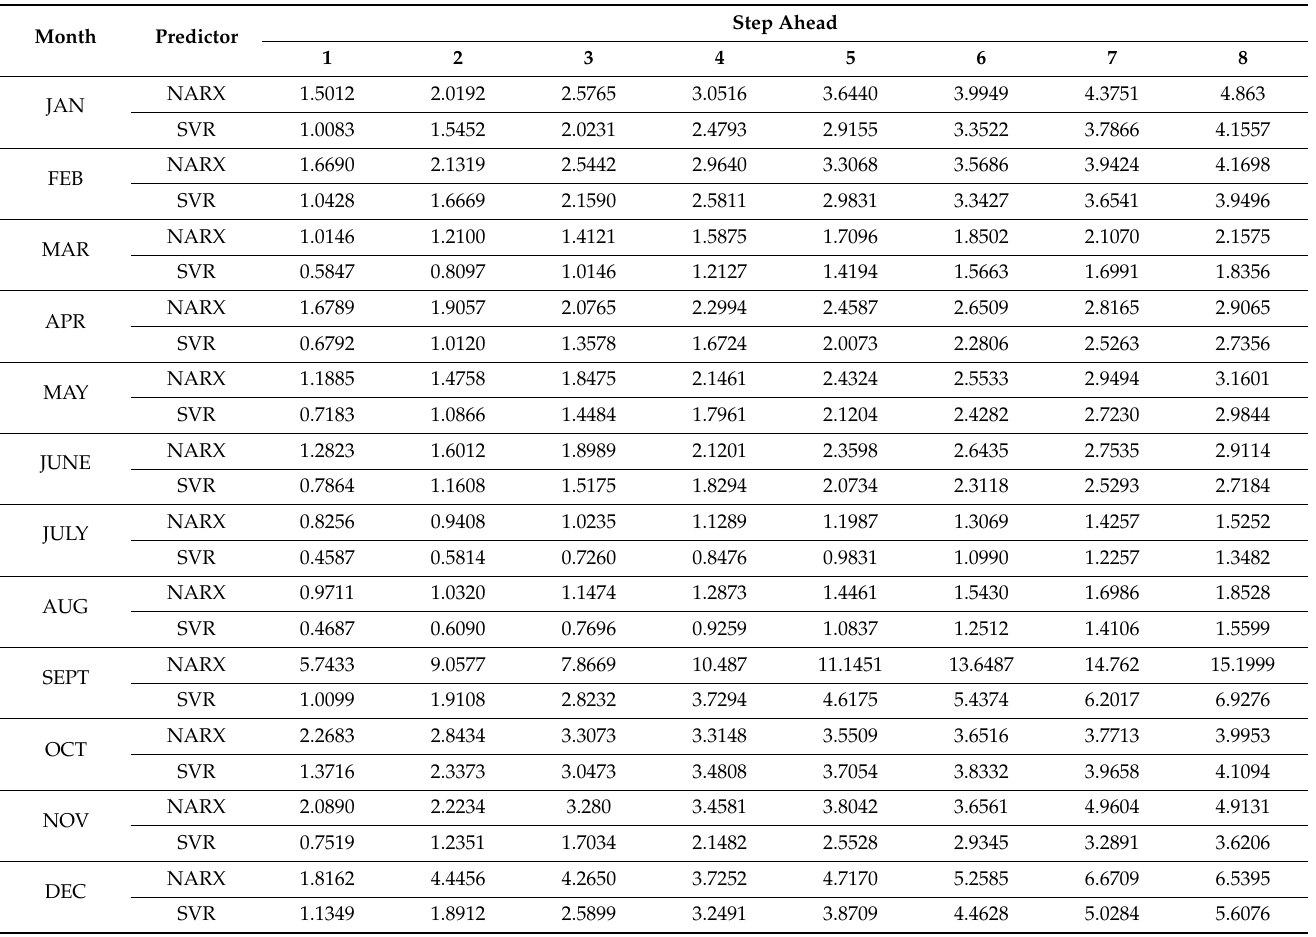
Figure 8. API values for Pasir Gudang in the years 2018 and 2019. Table 6. RMSE values for one- to eight-step-ahead predictions, according to month.